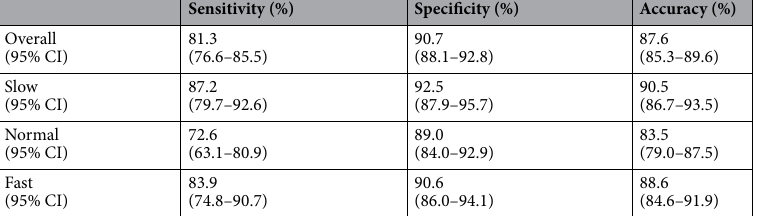
Table 4. Measures of sensitivity, specificity, and accuracy of speed of breathing. RR respiratory rate, BPM breaths per minute. We defined four scenarios of breathing: ‘no breathing’, RR = 0 BPM; ‘slow’, RR = 9 BPM; ‘normal’, RR = 18 BPM; and ‘fast’, RR = 30 BPM. RR 0 BPM data were excluded (n = 100). Incorrect answers regarging the presence of breathing were excluded (n = 8). CI confidence interval.